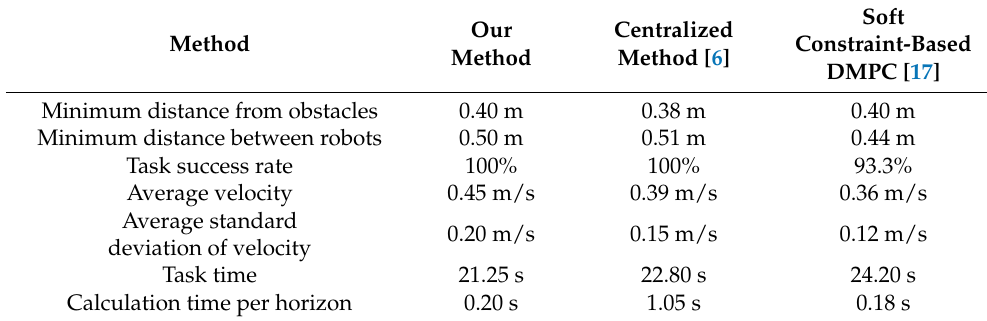
Table 3. Comparison between different methods.